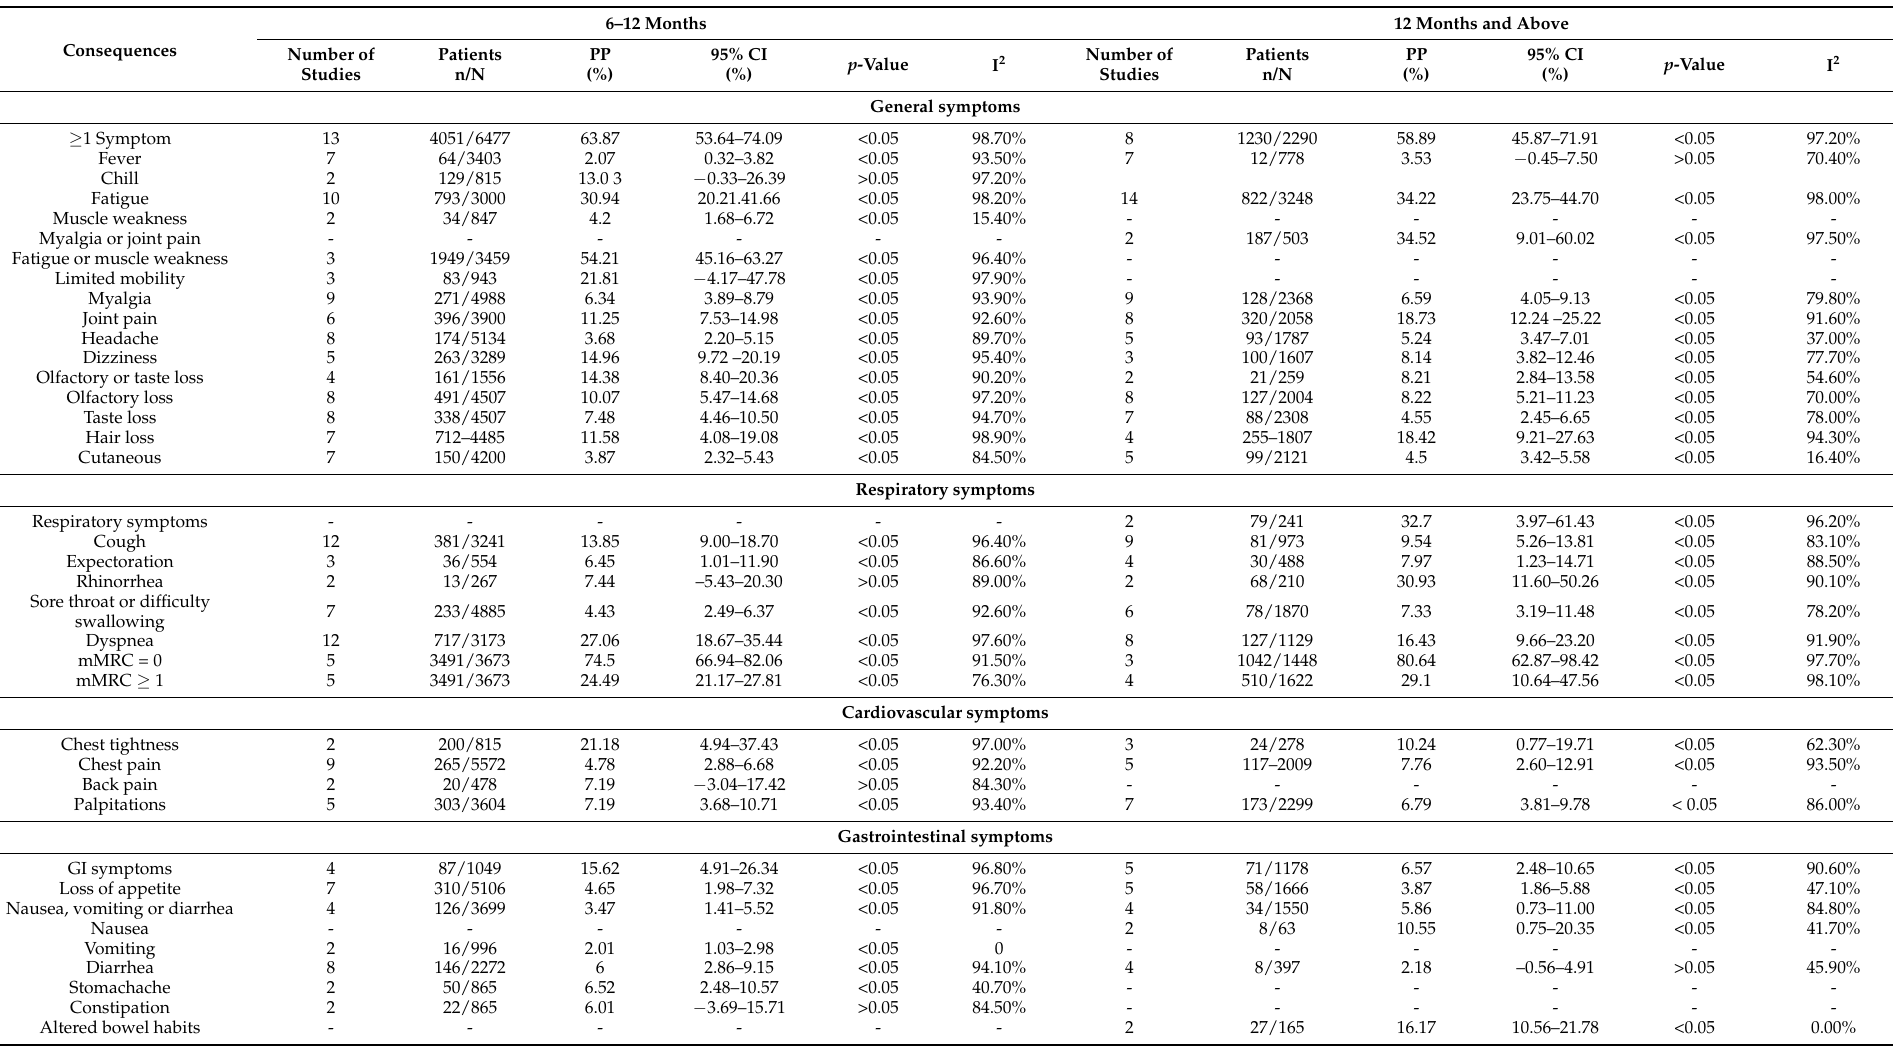
Table 1. Pooled prevalence of COVID-19 consequences at follow-up 6 months and